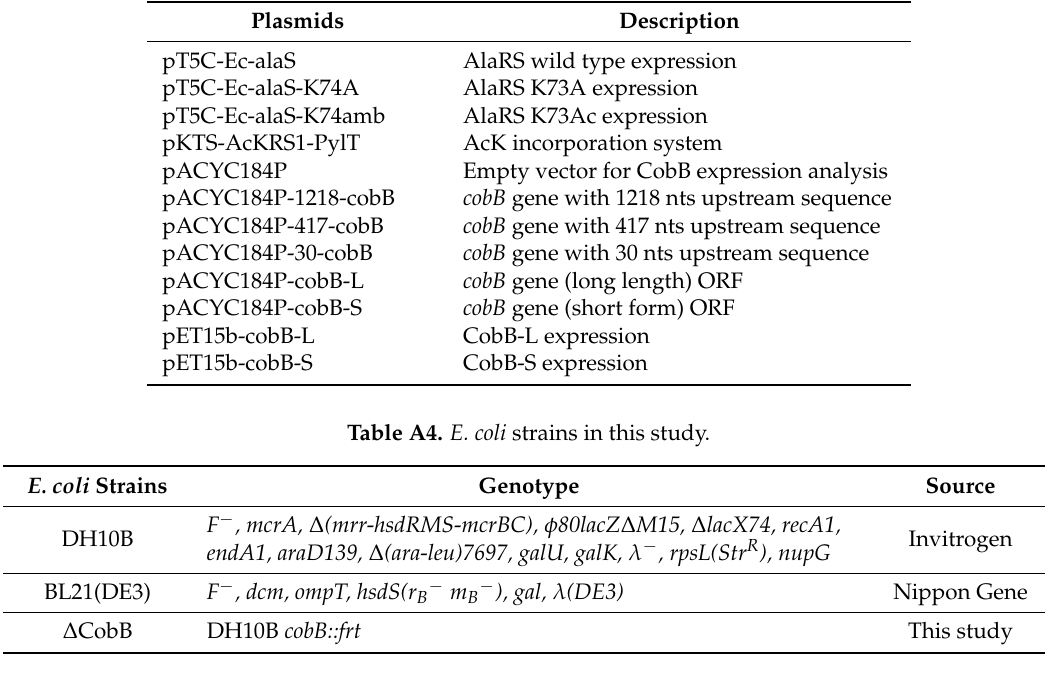
Table A3. List of plasmids in this study. nts, nucleotides.